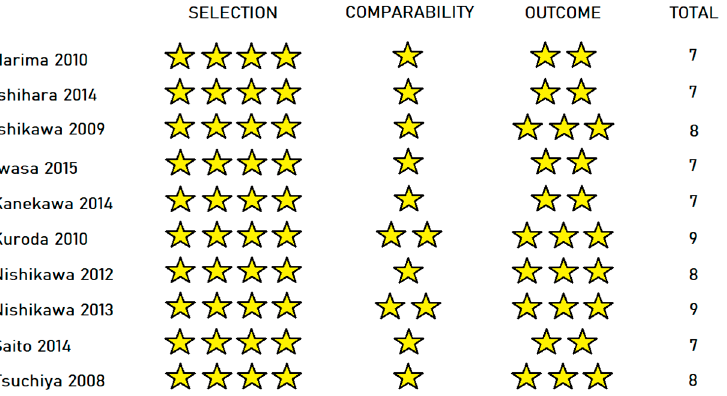
Figure 3. Results of the Newcastle–Ottawa scale for cohort studies [23–28,30,31,34,36].